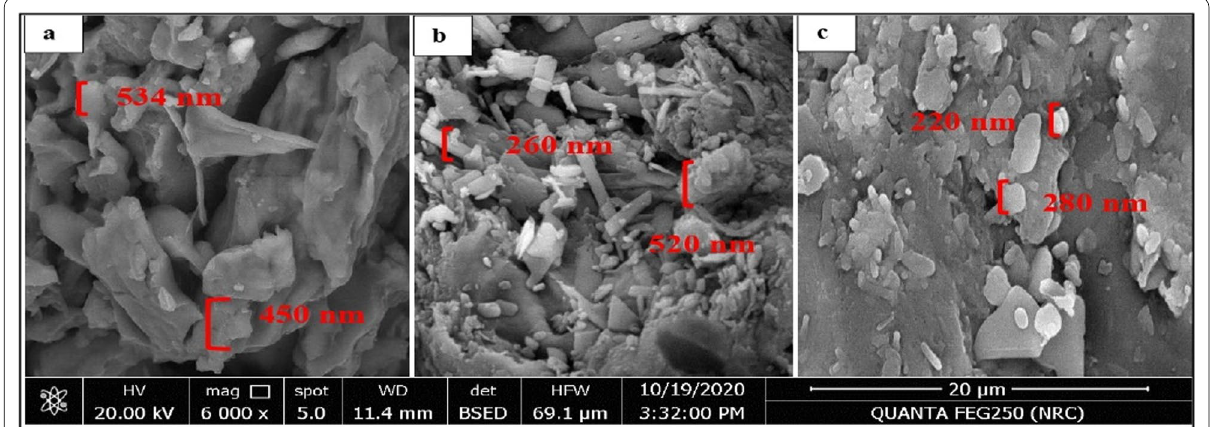
Fig. 3 The nanoparticles of chlorfenapyr ( a ), imidacloprid ( b ) and indoxacarb ( c ) under scan electronic microscope